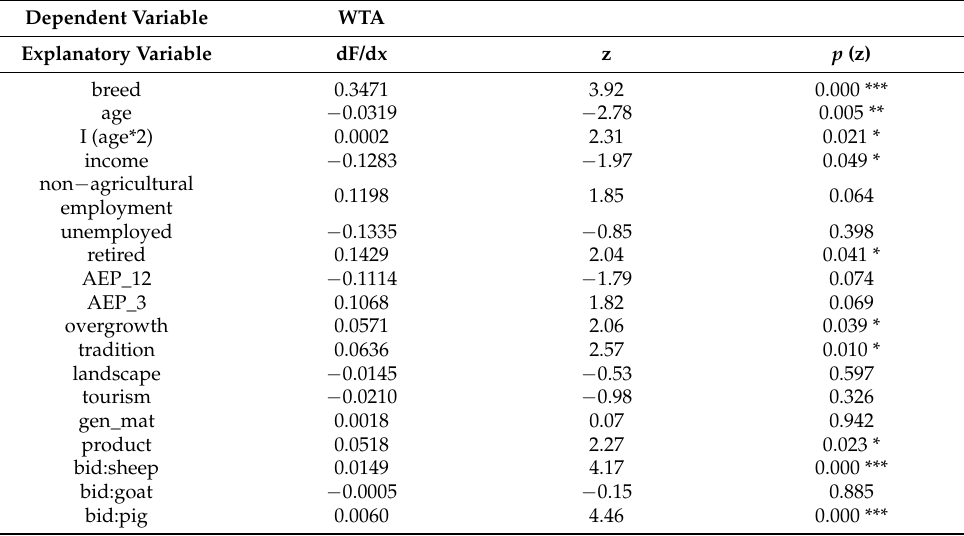
Table A1. WTA logistic regression estimation results, marginal